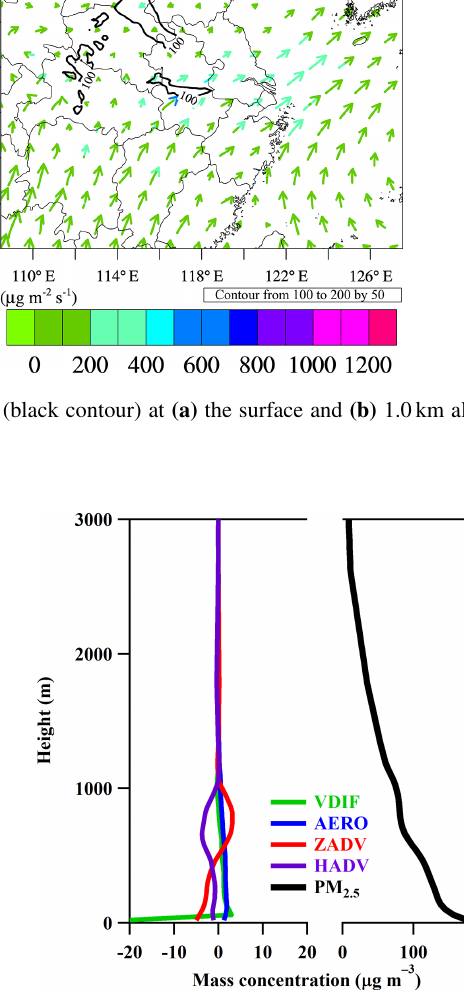
Figure 9. Vertical profiles of PM 2 . 5 concentrations and the con- tributions of physical/chemical processes to PM 2 . 5 concentrations during the period of stable